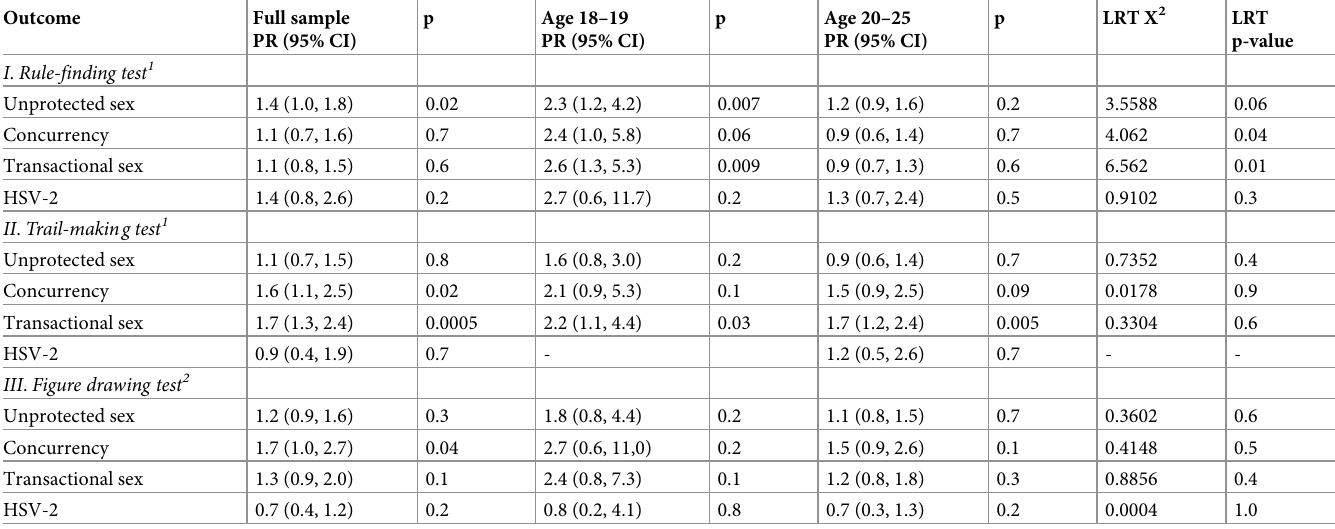
Table 2. The association between low executive function and sexual risk outcomes, among 853 young women in rural South Africa,